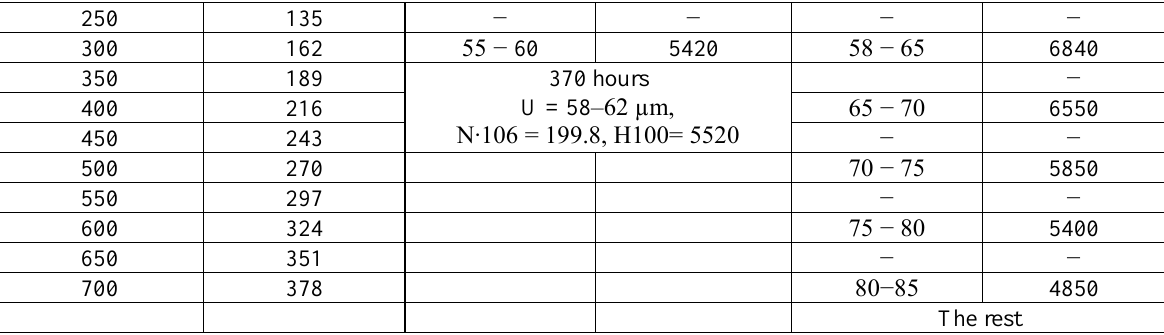
Physical, mechanical and tribological characteristics of samples with different coatings and their durability during rolling friction tests in oil I-20.